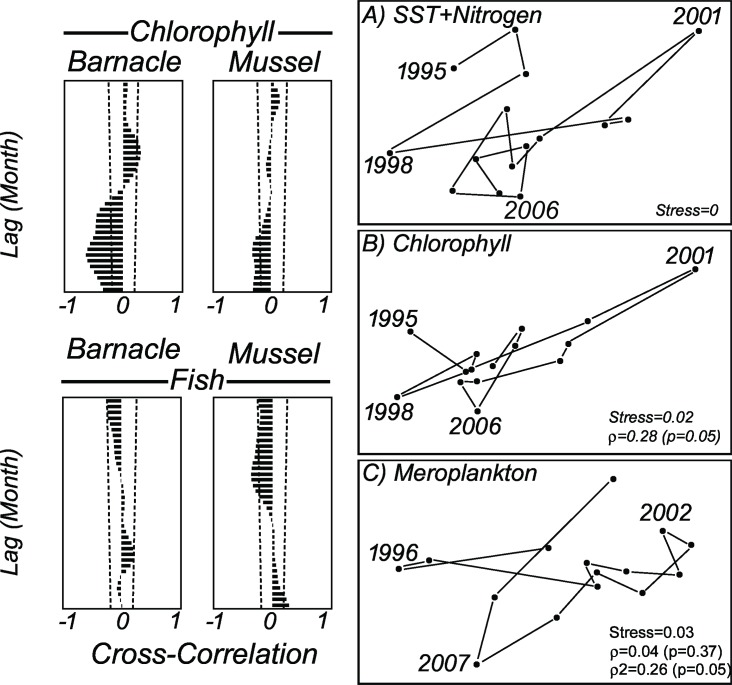
Correlation between major parameters time series and breakdown of temporal seriation.Left; Cross-correlogram (R) between chlorophyll a, meroplankton, and fish time series (N = 180 monthly smoothed anomalies). Top: chlorophyll a (non-lagged) and meroplankton (lagged); Bottom: meroplankton (non-lagged) and fish (lagged). The lag is in months. Right, Breakdown of seriation in inter-annual variation. Most important disruptions in (A) SST and nutrients, and (B) chlorophyll a trend that happen in 2001 and 2006 were followed by (C) meroplankton in the following years (2002/03 and 2007). Non-lagged Spearman rank correlation (ρ) and one-year lagged (ρ2) is shown inside the graph with p level in brackets.